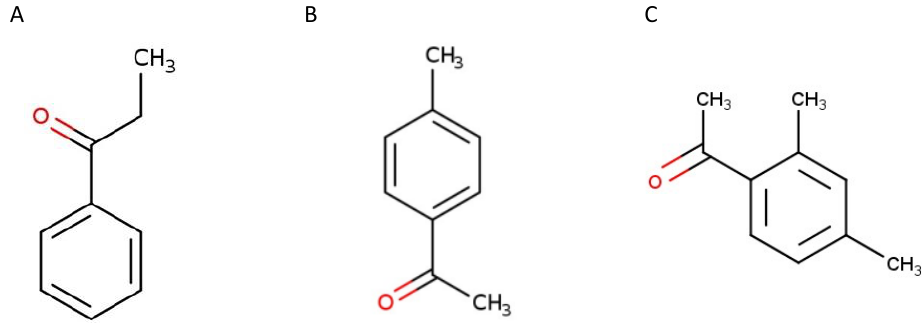
Figure Figure 1. Chemical structure of propiophenone ( A ), 4 ′ -methylacetophenone ( B ), and 2 ′ ,4 ′ -dime- thylacetophenone ( C ). Source: https://echa.europa.eu/ (access on 3 January 2023).